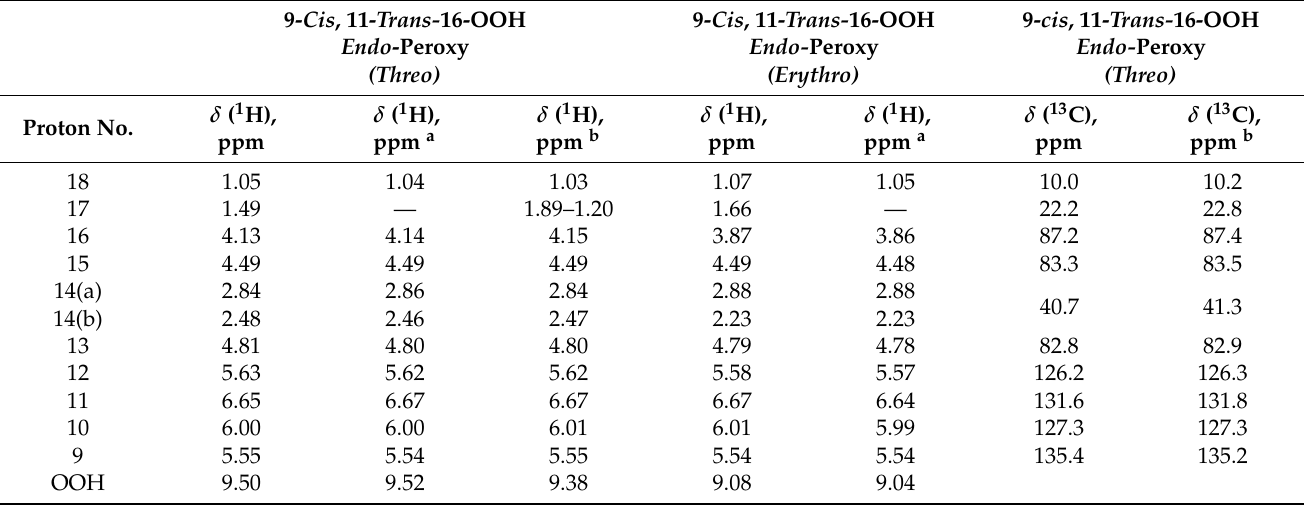
Table 9. Comparison of experimental 1 H- and 13 C-NMR chemical shifts of the 9- cis , 11 -trans